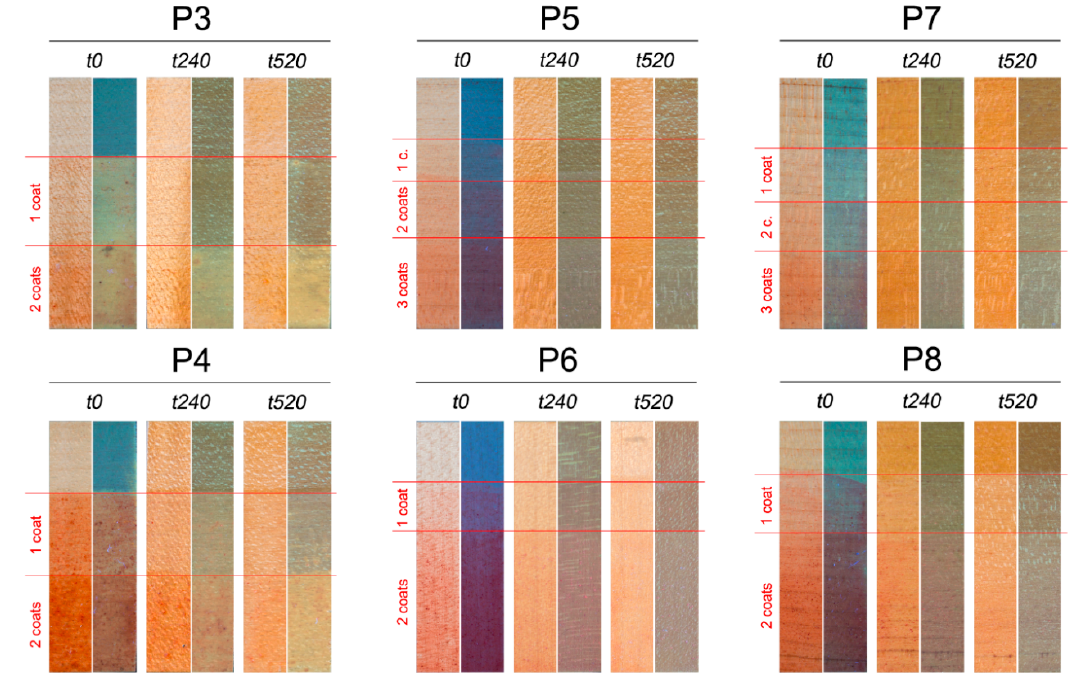
Figure 1. The considered mock-ups. Each of the six sets of images shows the same sample after increasing exposure times (namely t = 0 h, t = 240 h and t = 520 h). For the same exposure time, the sample is shown in visible (left) and UV (right) light illumination. Horizontal red lines separate areas where different subsequent coats of the lake-containing layer were applied.